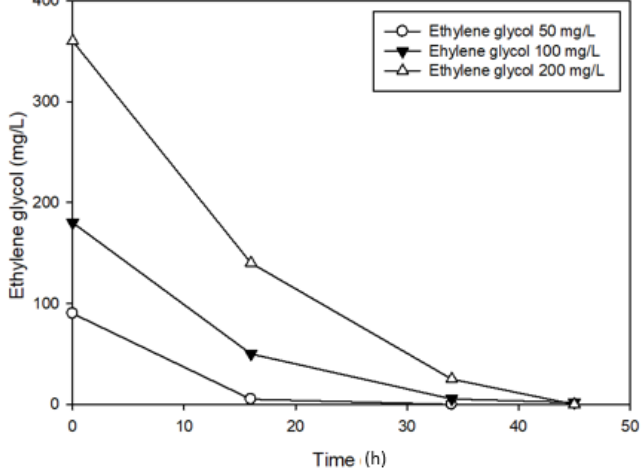
Figure 6. Biodegradation of ethylene glycol with various concentration. Water 2020 , 12 , x FOR PEER REVIEW